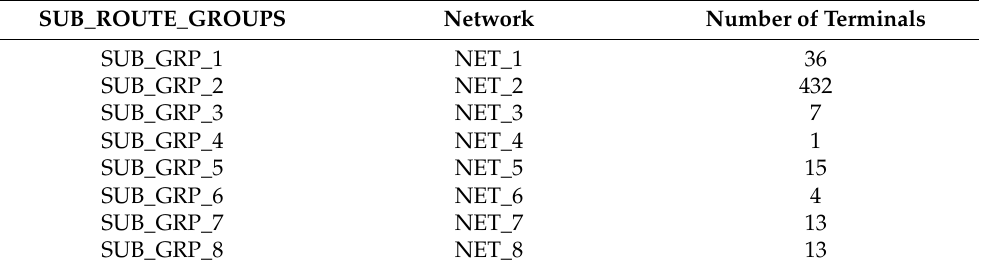
Table 1. Showing sub route groups, networks, and number of